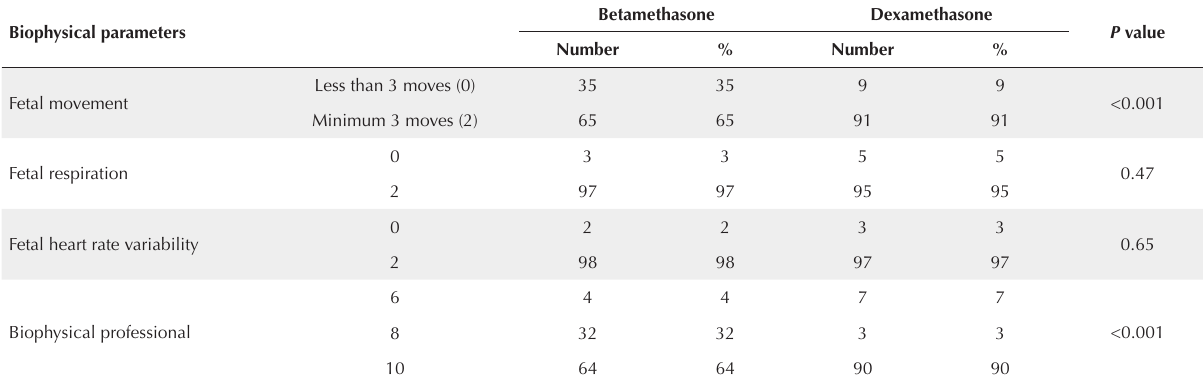
Table 2. Comparing the Effects of Dexamethasone and Betamethasone on Biophysical Parameters Biophysical